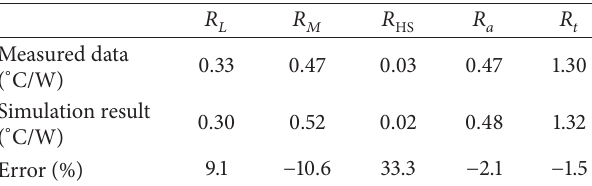
Table 2: Comparisons between experimental and numerical ther- mal resistances of D.C. 30